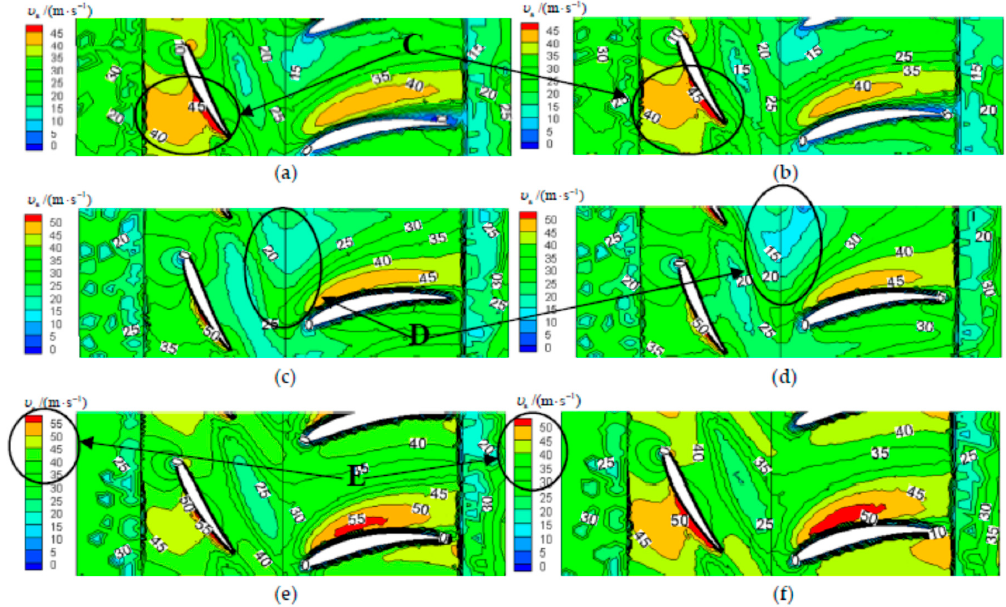
Figure 10. Distribution of the axial velocity at the section of R = 1. ( a ) β = 29°, θ = 0°; ( b ) β = 29°, θ = 3.0°; ( c ) β = 32°, θ = 0°; ( d ) β = 32°, θ = 3.0°; ( e ) β = 35°, θ = 0°; ( f ) β = 35°, θ = 3.0°.